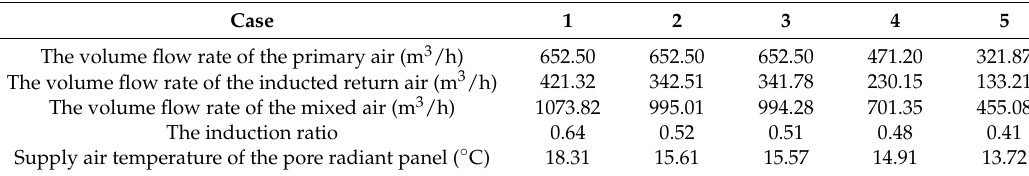
Table 2. The calculated results of the five